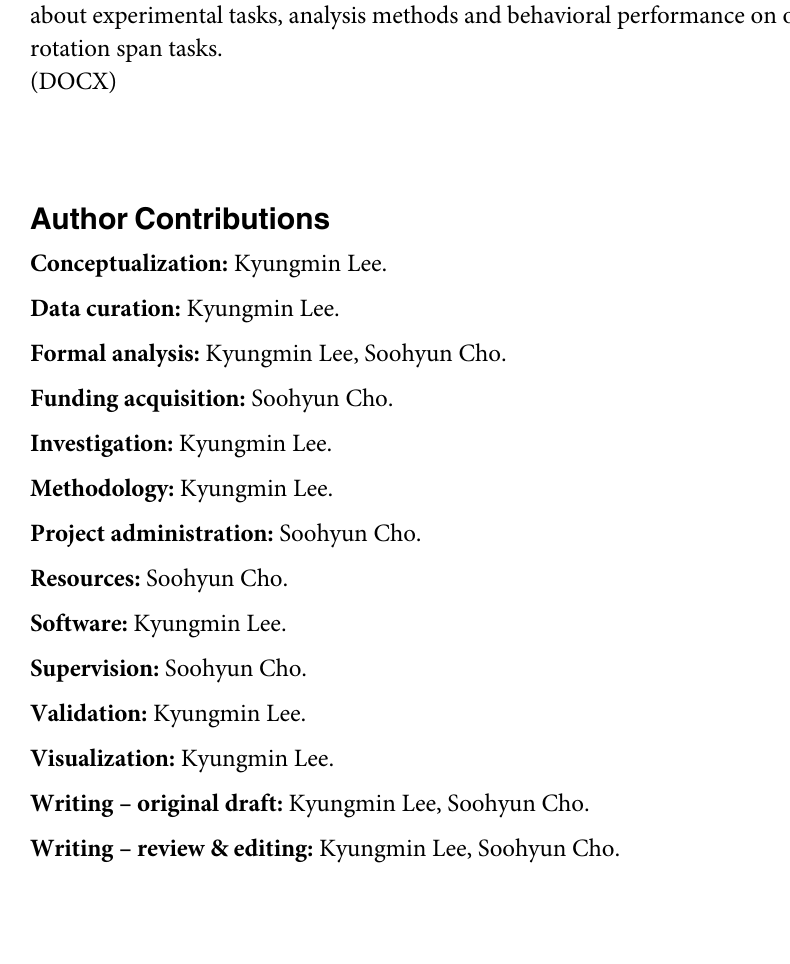
S2 Table. The ratios of numerical and non-numerical visual magnitudes in each condition. S3 Table. The list of trial-based ANCOVAs on performance using Group as the within- trial factor, Condition as the between-trial factor along with covariates. S4 Table. The list of trial-based hierarchical regression analyses conducted on accuracy for each group. S1 Fig. The ratios of numerical and non-numerical visual magnitudes used in the stimuli of the numerosity comparison task. Trial types are depicted in four different ways, in terms of the relationships between the numerosity ratio and each non-numerical visual magnitude ratio. Each point represents a certain type of trial (contains 10 trials each). The horizontal line in each figure defines the boundary that separates the Congruent ( > 1) and Incongruent ( < 1) conditions. S2 Fig. The distributions of Verbal and Visuo-spatial EWM scores. The analysis of skewness and kurtosis revealed that none of the scores exceeded + or –